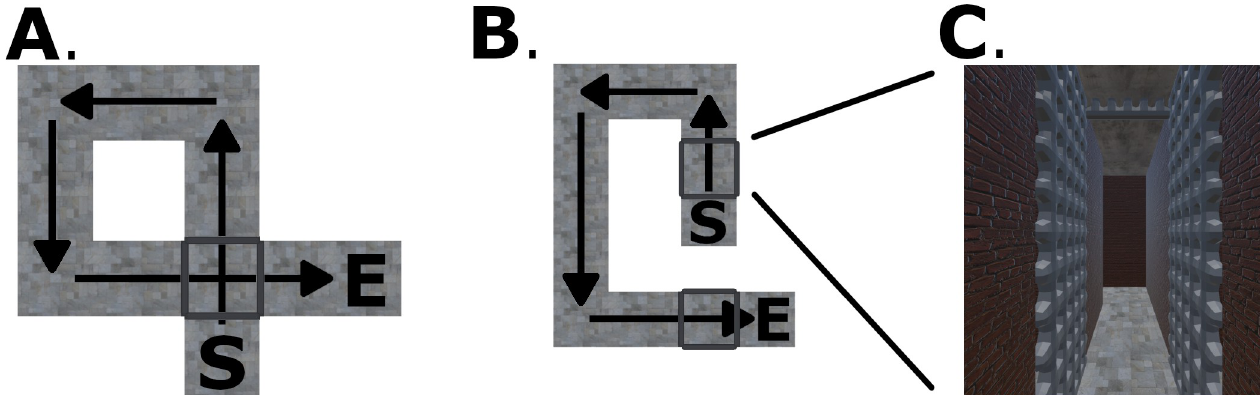
Fig 6. Example paths in Experiment 2 for the (A) true intersection cross (TI-C) and (B) false intersection no cross (FI-NC) conditions. (C) shows a leg of the hallway with the obscuring gates at a false intersection from the participant’s perspective.